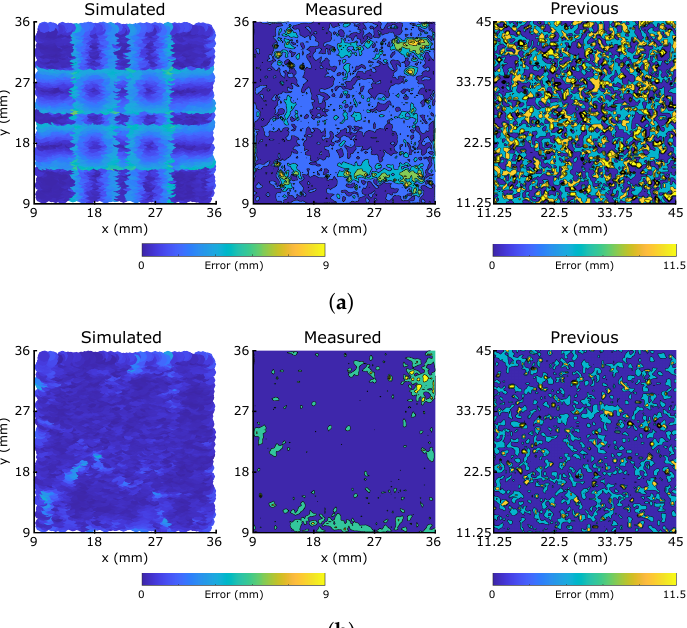
Figure 8. Simulated and measured x − y localization error distributions of single layer networks trained on 5000 presses of the two sensor morphologies, over the 25 × 25 mm area marked in Figure 5. The color bar covers the 9 mm grid size used for the physical prints. ’Previous’ refers to the manually fabricated sensor networks in [30], with an equivalently scaled color bar for the 11.25 mm grid size. ( a ) Grid; ( b )